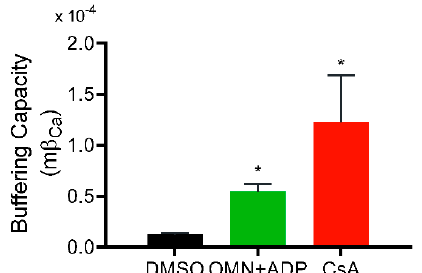
ff ect of CsA and AdN on mitochondrial Ca 2 + bu ff ering capacity. Mitochondrial Ca 2 Figure 4. Effect of CsA and AdN on mitochondrial Ca 2+ buffering capacity. Mitochondrial Ca 2+ Figure 4. E